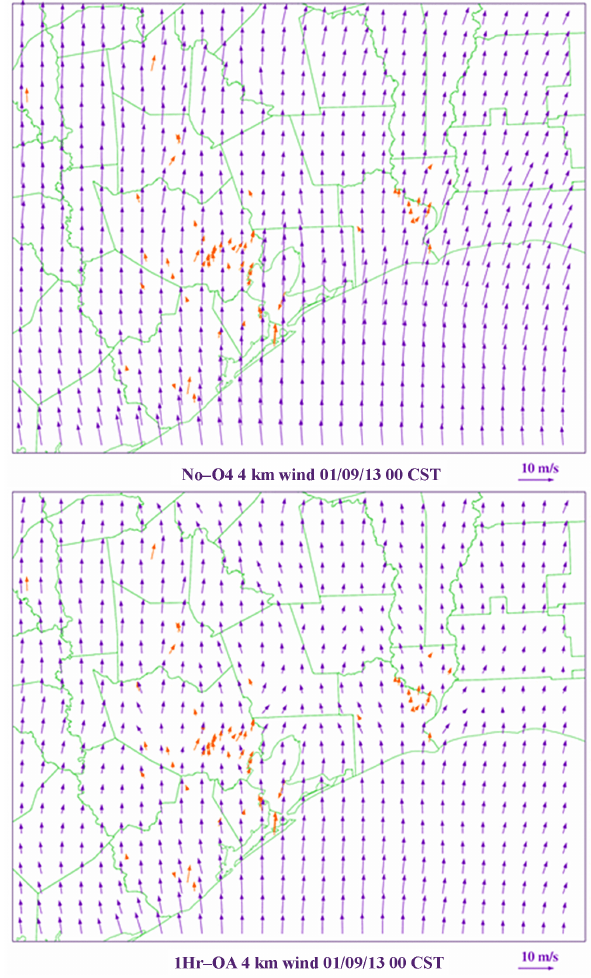
Figure 5. Model and observed winds on 1 September at 00:00CST: No-OA (top panel) and 1Hr-OA (bottom panel). Model winds are blue arrows and the observations are orange arrows. Stronger southerly winds, especially along coastal region, were reduced in the OA